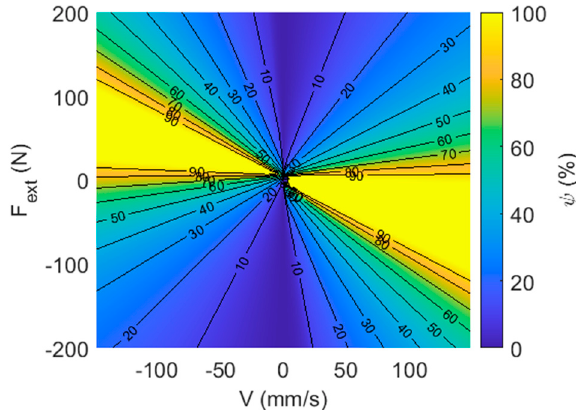
Figure 12. Fraction of input power lost to friction for the valve B system.